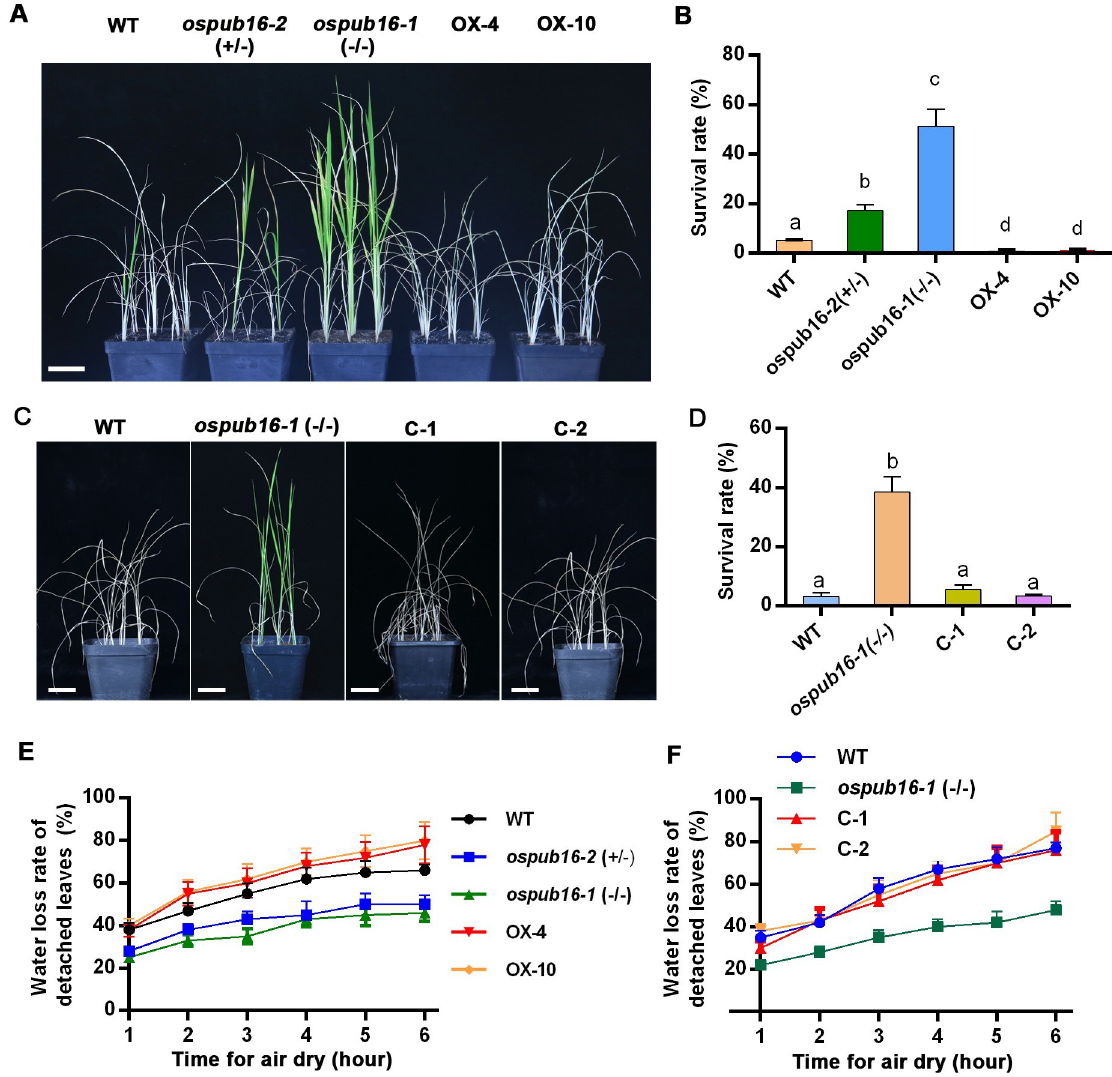
Fig 2. Response of the ospub16 mutants and OsPUB16 overexpression lines to water deficit stress. (A) Images showing the phenotypes of wild type (WT, Nipponbare), ospub16 mutants and OsPUB16 overexpression lines (OX-4, OX-10) after water deficit stress for 12 days and then rewatering for 5 days. Scale bars, 3 cm. (B) Survival rates of different genotypes after water deficit stress and then rewatering as described in (A). Data are means ± SD ( n � 48). (C, D) Complementation test of ospub16-1 mutant. WT, ospub16-1 mutant and complementary lines (C-1, C-2) were exposed to deficit stress for 13 days and then rewatering for 4 days. Data are means ± SD ( n � 27). Scale bars, 3 cm. (E) Water loss rates of detached leaves from 2-month-old plants. Data are means ± SD ( n = 10). (F) Water loss rates of detached leaves from 1-month-old plants. Data are means ± SD ( n = 10). In (B) and (D), two-way ANOVA followed by Bonferroni’s post- hoc test was performed. Different letters with the same superscript mark indicate significant differences ( p < 0.05) between plants under the same